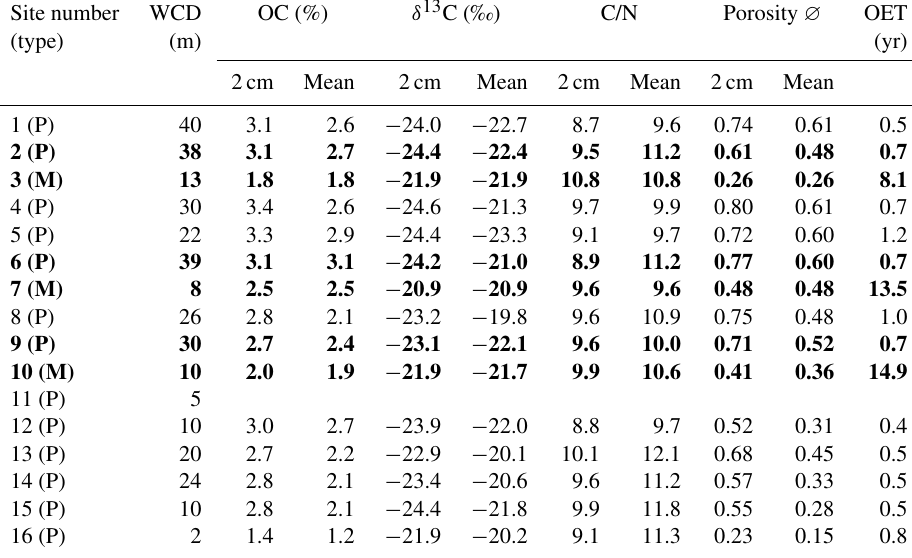
Table A1. Water column depth (WCD) and characteristics of post- flooding sediment (top 2cm and mean) and oxygen exposure time in sediment (OET). Note that at site 11 sediment accumulation was zero. Sites close to the margin (M) and in the pelagic zone (P) in the same transects perpendicular to the rivers–dam transect are bold- faced. Numbering started at the dam (i.e., site 16 is furthest away from the dam; see Fig.